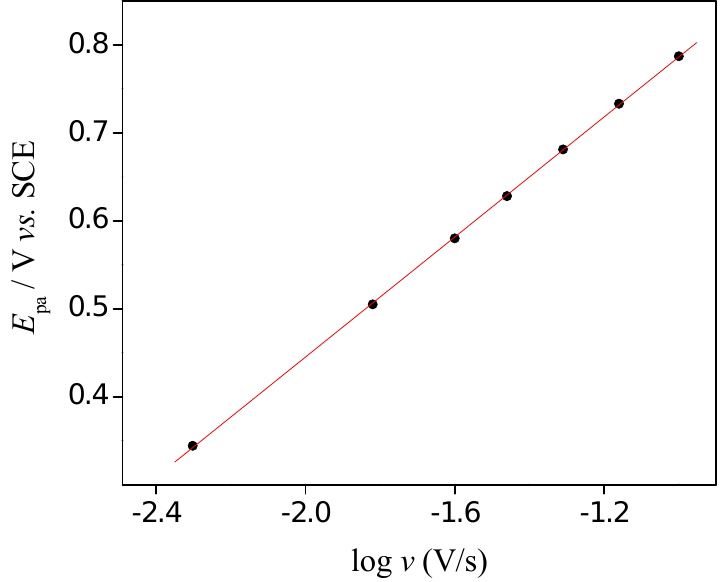
Figure 3. Dependence of E pa with log( ν ) for the sensor in Tris buffer solution (pH = 8) containing 4.8 x 10 − 4 mol L − 1 potassium ions